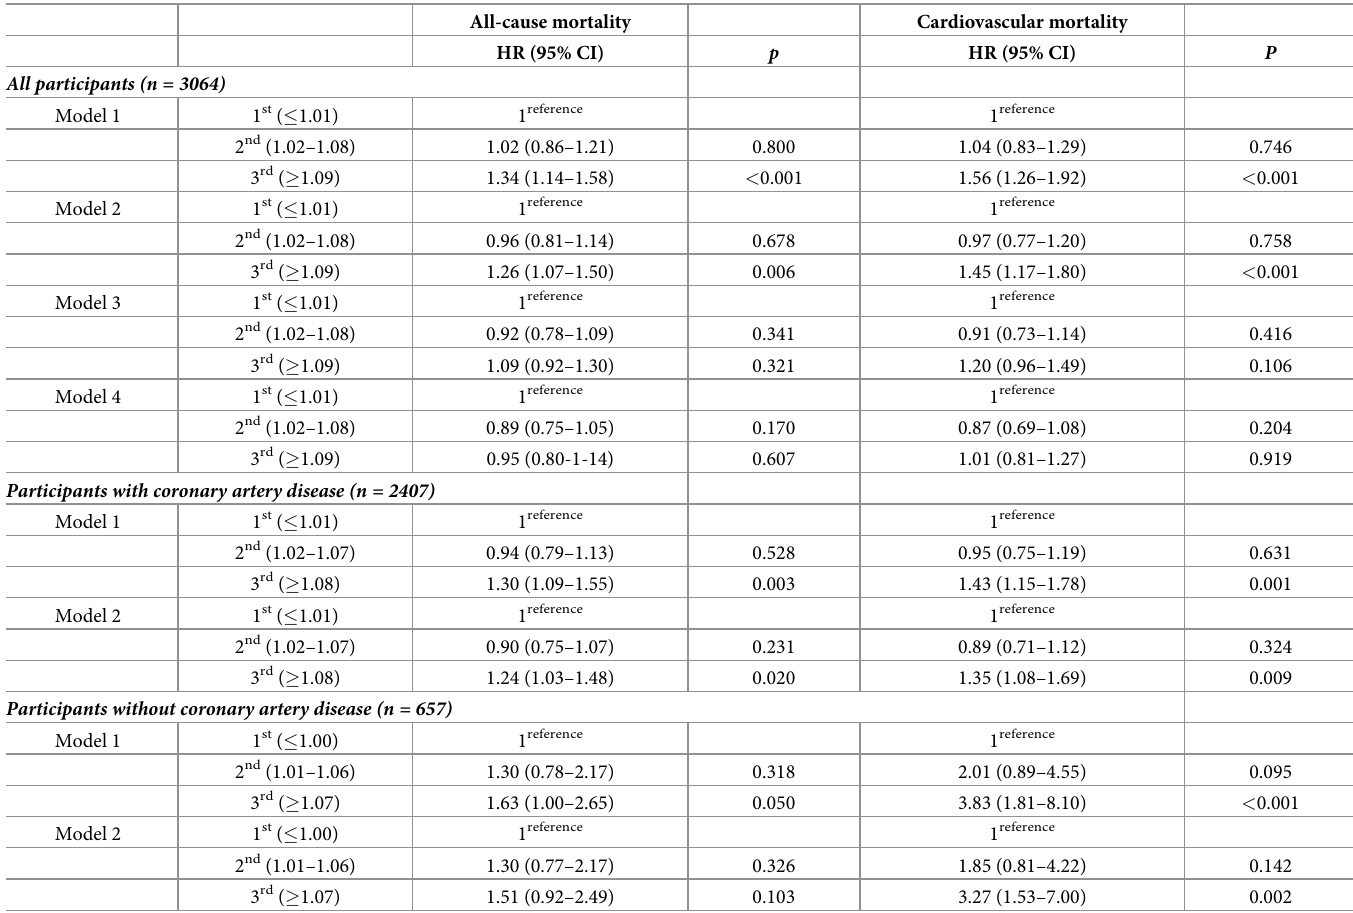
Table 3. All-cause mortality and cardiovascular mortality according to tertiles of INR.